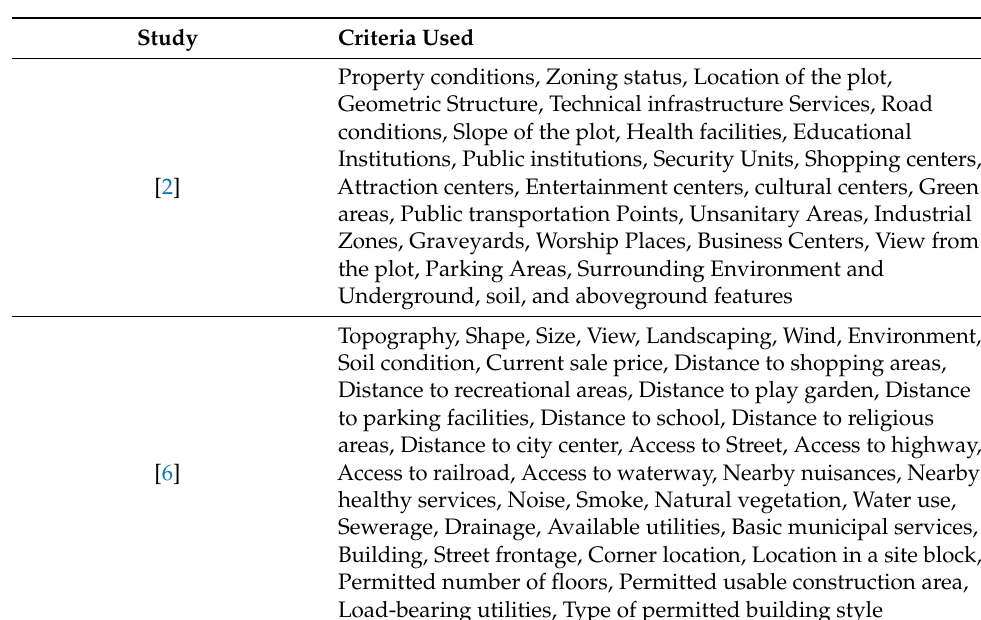
Figure 2. General flowchart of the research. Table 1. Criteria used in